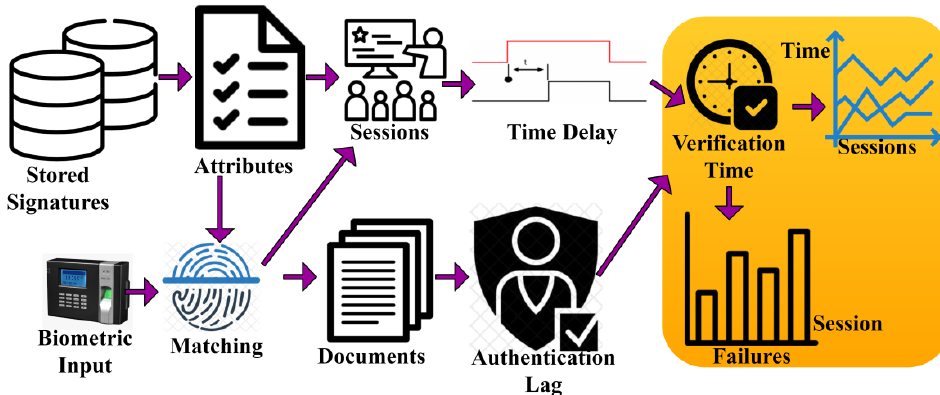
Figure 7. Independent analysis.